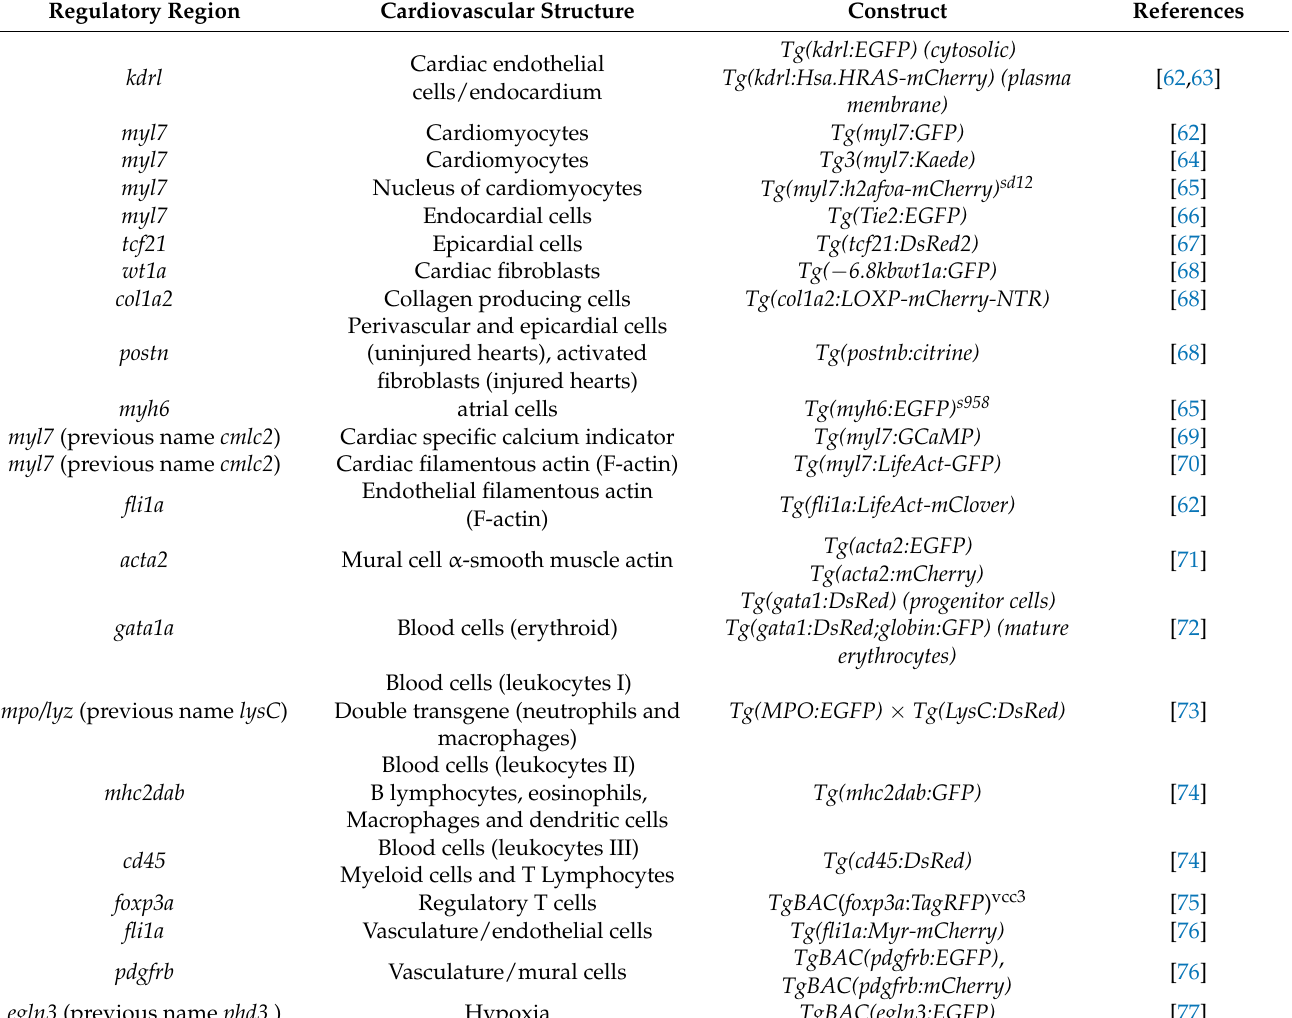
Table 2. Fluorescent reporter lines with expression anatomy in the cardiovascular system and other systems of interest for heart transplantation research. Cardiovascular